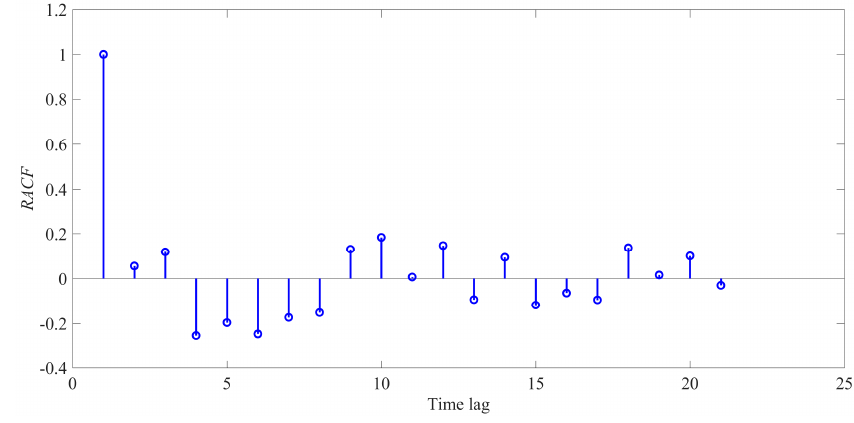
Figure 8. RACF result for SDM.